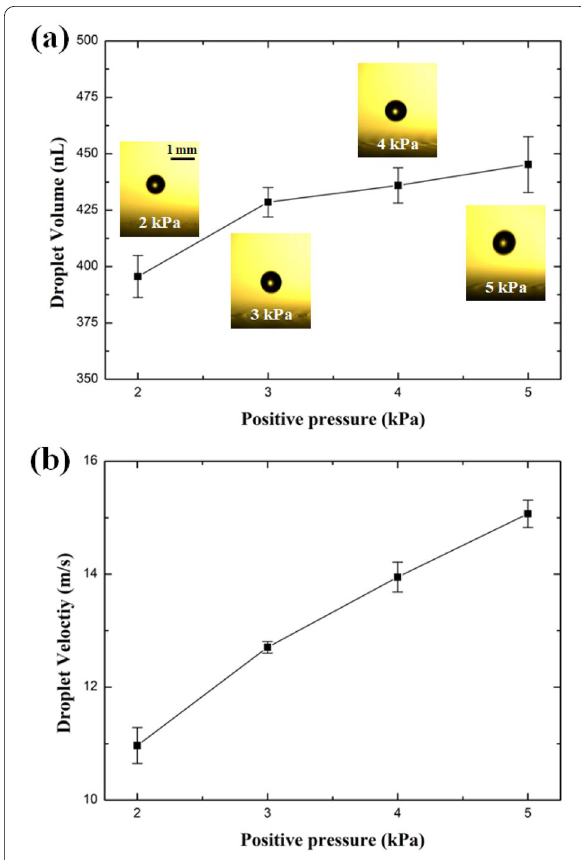
Fig. 7 Measurement results of a droplet volume and b velocity of ejected droplet according to positive pressure (n